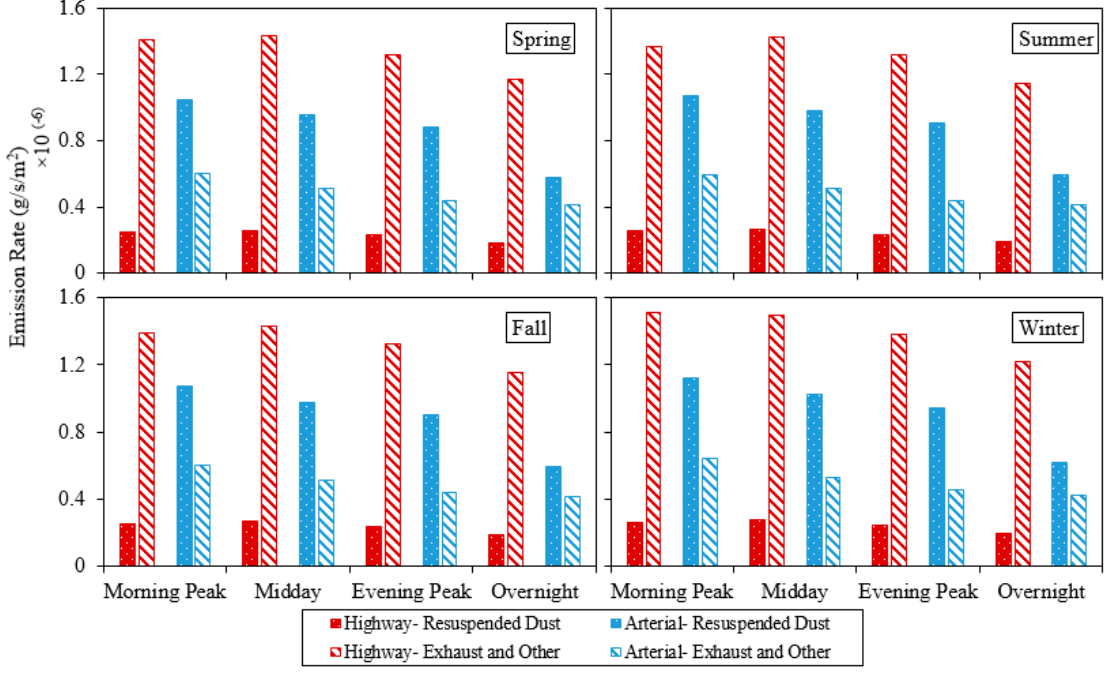
Figure 2. Predicted fine particulate matter (PM 2.5 ) emission rates.